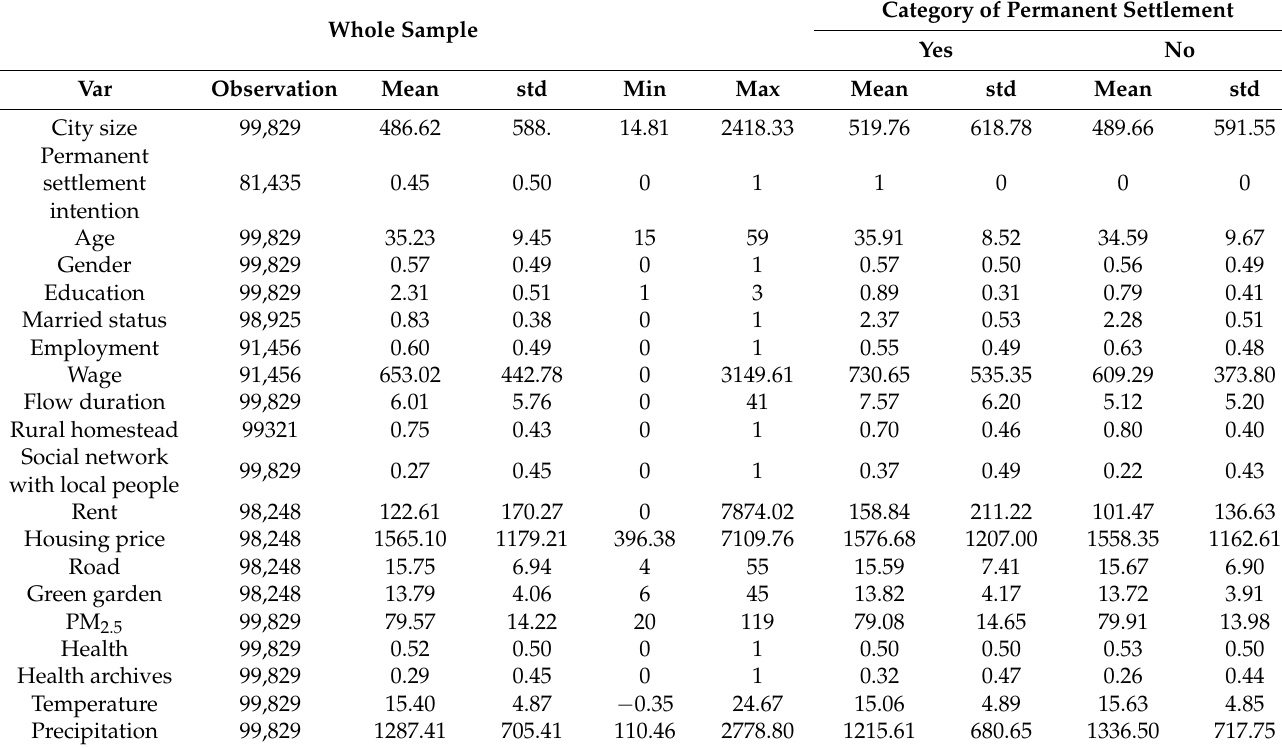
Table 2 provides the descriptive statistics for the variables. Among the migrants, nearly half of them want to settle permanently in the city. From the overall trend of migration, the migrants are young, with an average age of 35 years old. The average duration length of migration is six years, and the average monthly wage is 4146.61. The wage level has significant group heterogeneity, with the lowest value of 0 and the highest value of 20,000 yuan. Besides, 75% of the migrants own the homestead in their hometown. For the social network in the city, gathering with fellow villagers from the same hometown in their spare time is the first choice, and such group accounts for nearly half. Only 27% of the migrants chose to have the closest contact with residents, and the remaining 20% of the migrants didn’t communicate with anyone. There is also significant heterogeneity in housing prices. The lowest urban house price is 2517 yuan per square meter, while the highest one is 45,147, with a difference of nearly 20 times. Table 2. The descriptive statistics of